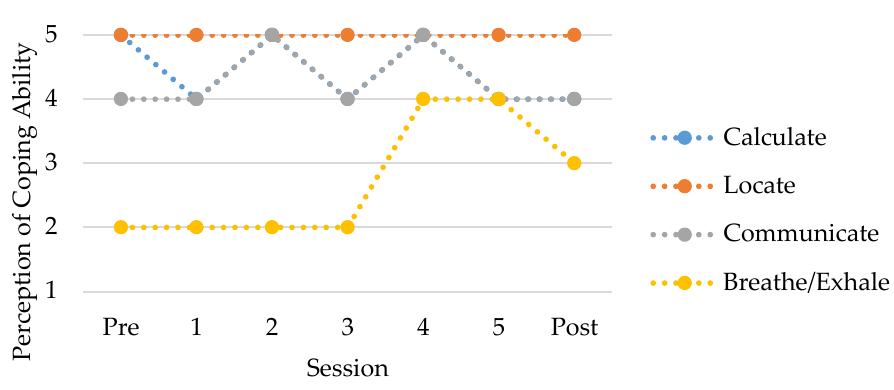
Figure 1. Parent responses to coping strategies through the duration of EMBRace.